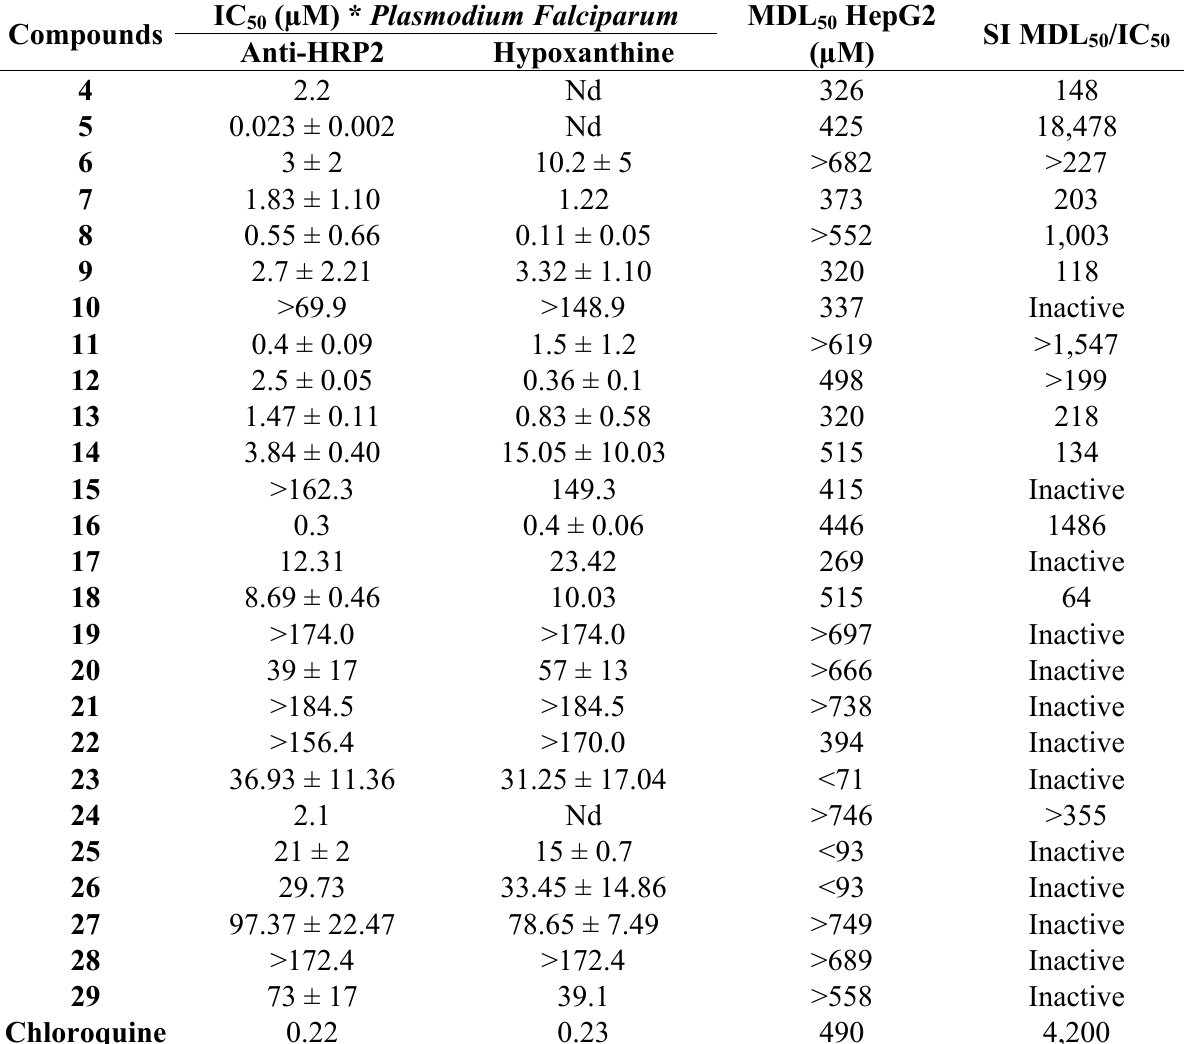
Table 1. Evaluation of anti-plasmodial activity against a chloroquine-resistant W2 clone of P. falciparum , cytotoxicity against a human hepatoma cell line (HepG2) and drug selectivity index (SI) of compounds 4–29 and